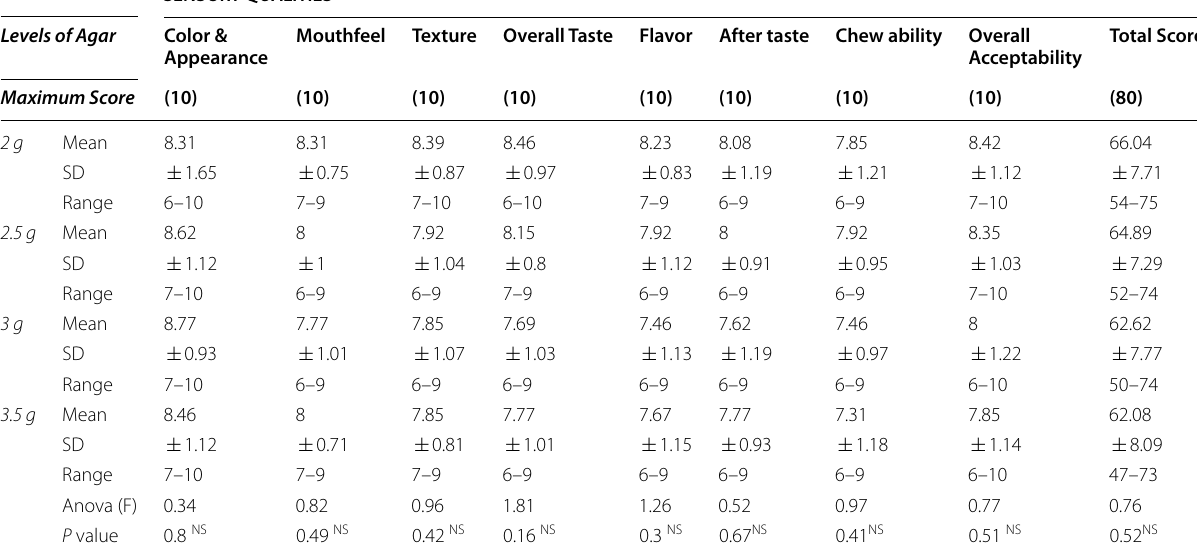
Table 3 Standardization with varying levels of agar addition